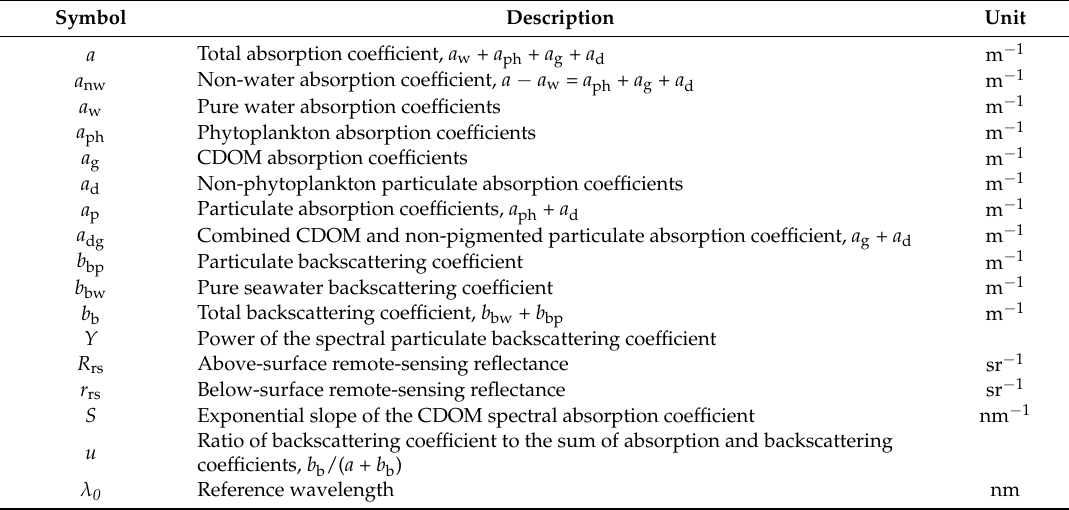
Table 1. Symbols and